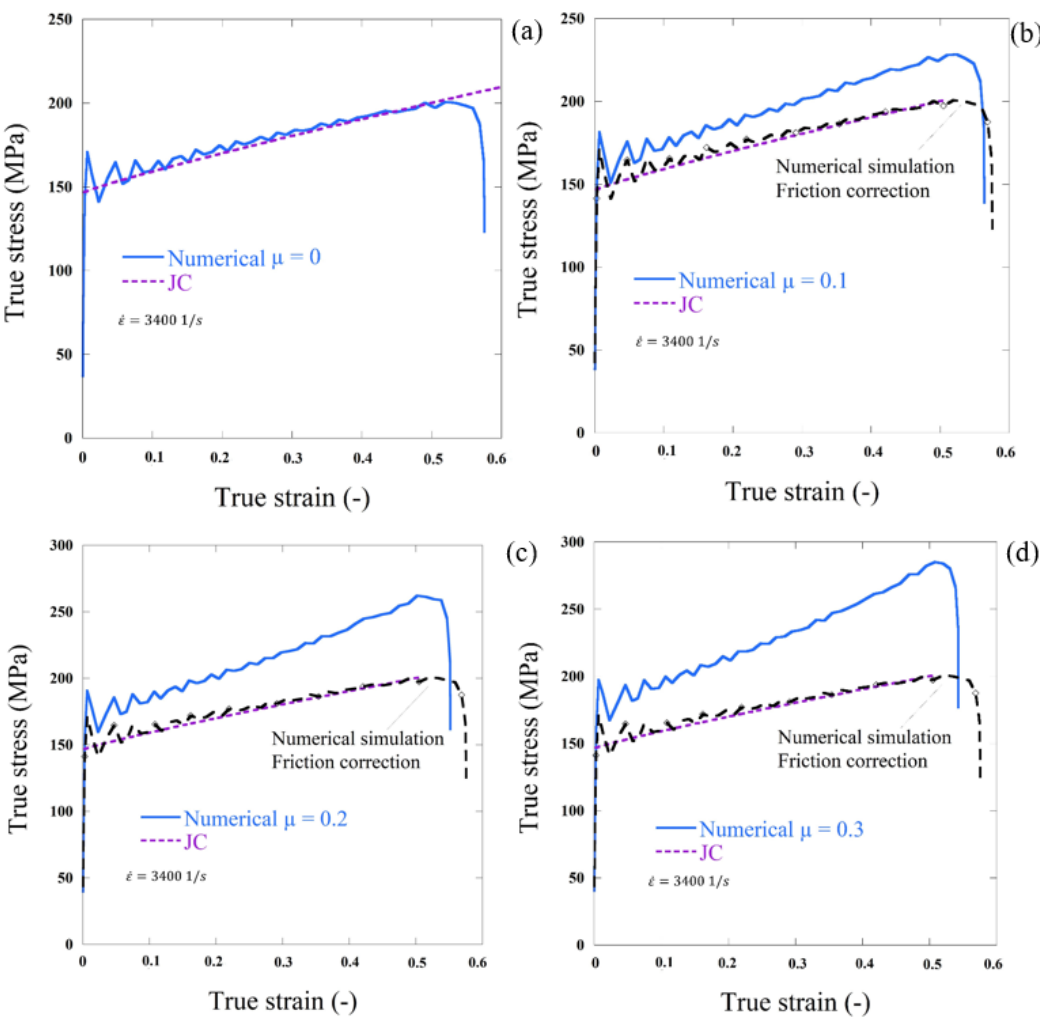
Figure 11. Results of SHPB simulation and ( a – d ) comparison between numerical results with Johnson cook model (JC) model for different friction coefficients using the cylinder sheet. 𝜀(cid:4662) = 3400 1/s .